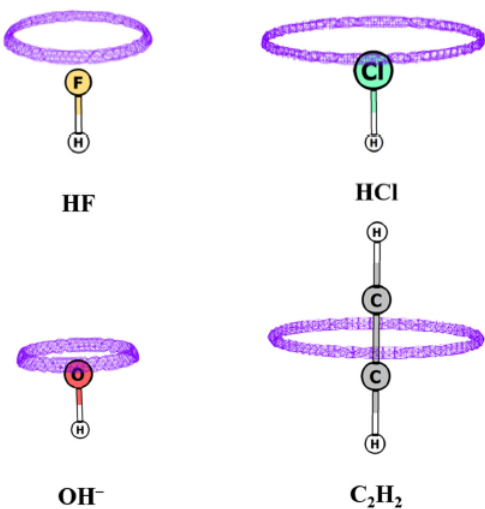
Figure 4. MESP topology of some molecules calculated at B3LYP/6-311G (d, p) level theory. Degen- erate ring of CPs of (2, 0) type lies inside the isosurface for each molecule. Isosurface values are: − 30, − 10, − 280, − 20 kcal/mol for HF, HCl, HO ¯ and C 2 H 2 ,